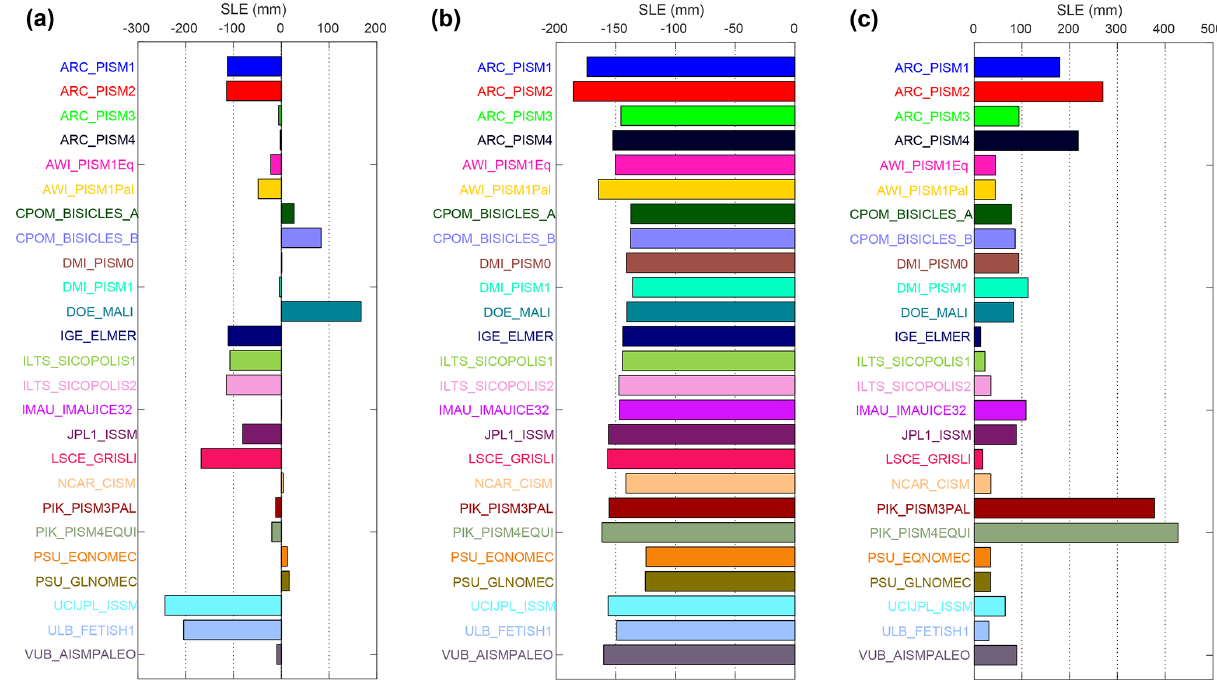
Figure 4. Antarctic contribution to sea level (mm of sea level equivalent). (a) ctrl experiment, (b) difference between asmb and ctrl experi- ments, and (c) difference between abmb and ctrl experiments. Negative values of SLE represent a growing ice